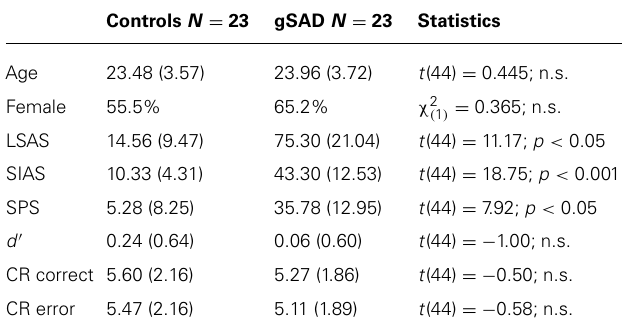
Table 1 | Demographic and control